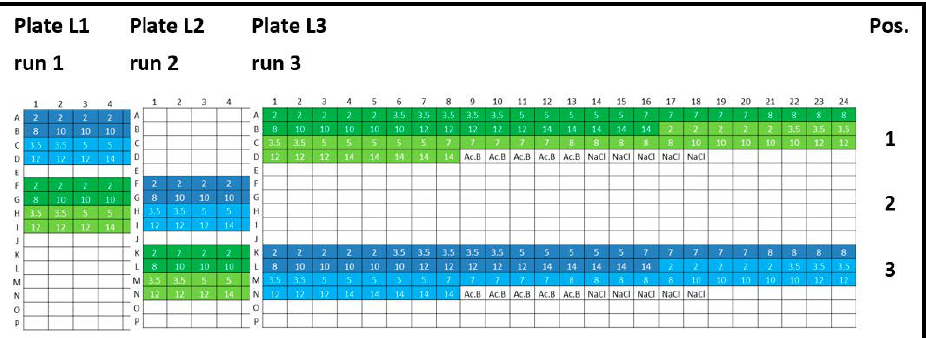
Figure 1. Experimental plate designs for intra-plate variability. Lysozyme (L): three 384-well plates were analyzed (run 1, run 2, and run 3), and the concentration series was arranged horizontally (2, 3.5, 5, 7, 8, 10, 12, and 14 mg/mL). Lysozyme batch types: LysSig2243 (blue), +400-mM NaCl (cyan) and LysSig5161 (green), +400-mM NaCl (light green). Control samples: Ac.B: 20-mM acetate buffer, pH 4.5, and NaCl: 400-mM of sodium chloride in acetate buffer, pH 4.5.